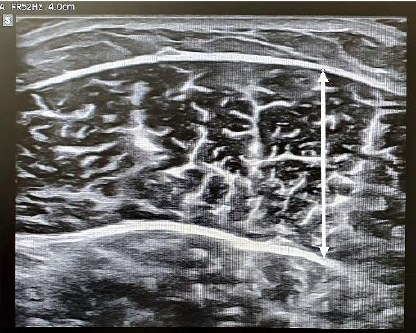
Figure 2. The muscle thickness was measured maximum distance between the